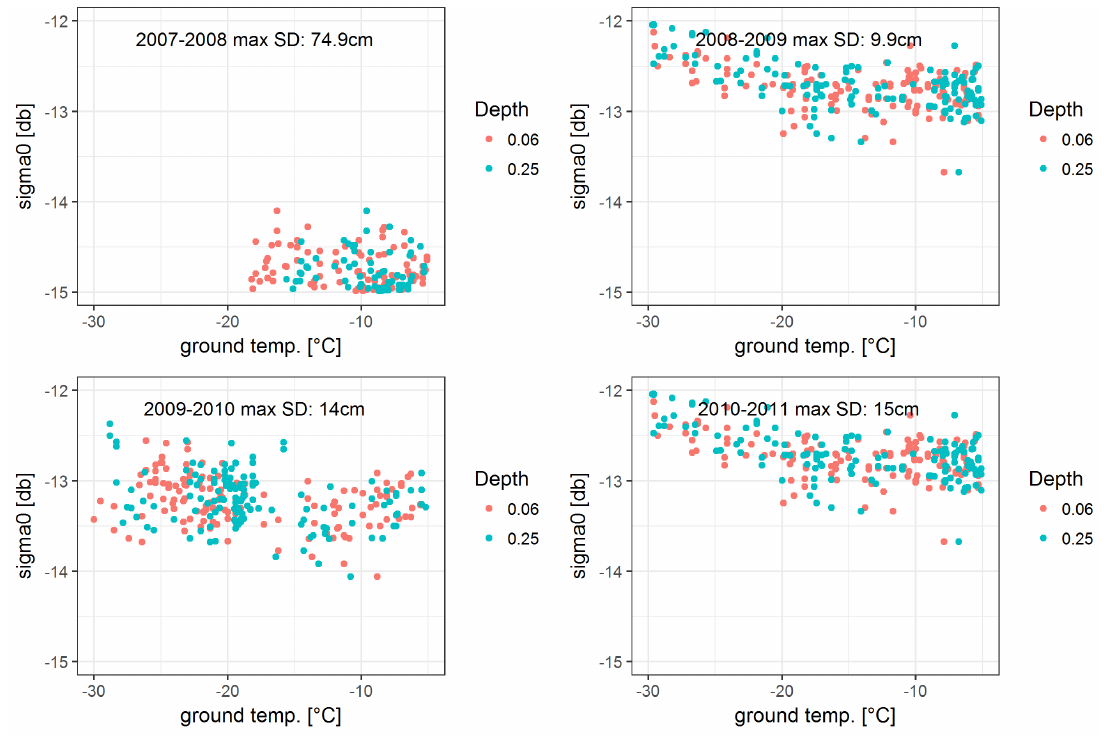
Figure 6. ASCAT backscatter (dB) and ground temperature (°C) values for selected winters (November–March) for Borehole VD–1 (Yamal, Russia); maximum snow depth (SD) values were extracted for WMO station Marre–Sale Nr. 23032 (69.72, 66.8194).